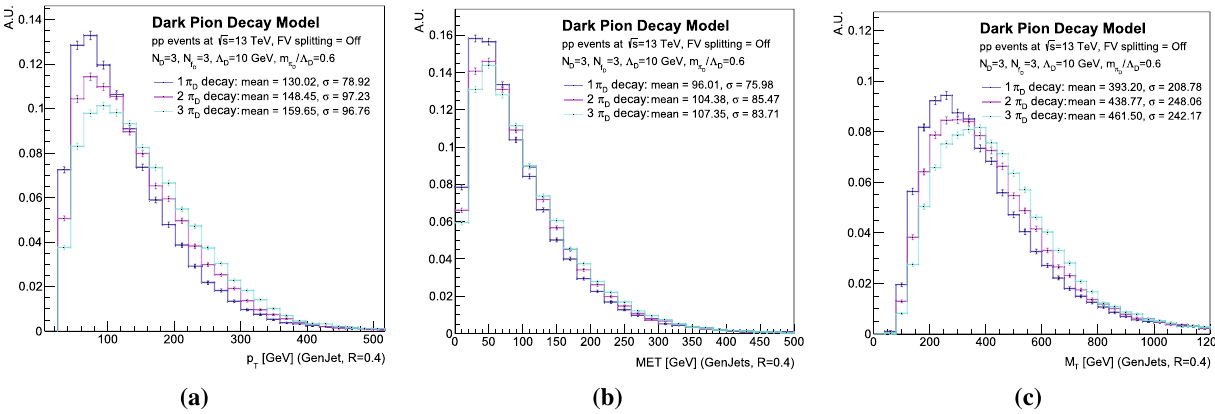
Fig. 37 Comparison of kinematic variable distribution for 1, 2 and 3 dark pions decay: a p T distribution of the leading jet in the event, b (cid:3) E T distribution, c distribution of M